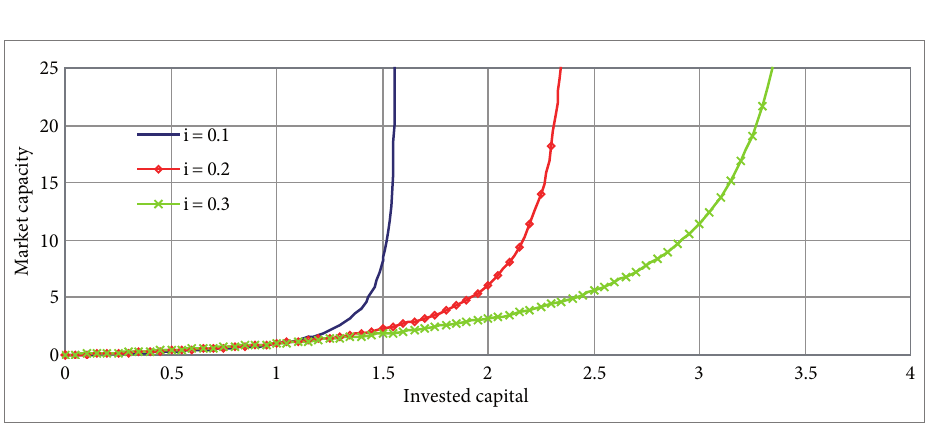
Fig. 3. Dependency of market capacity (potential value of size) on the amount of invested capital at existing various interest